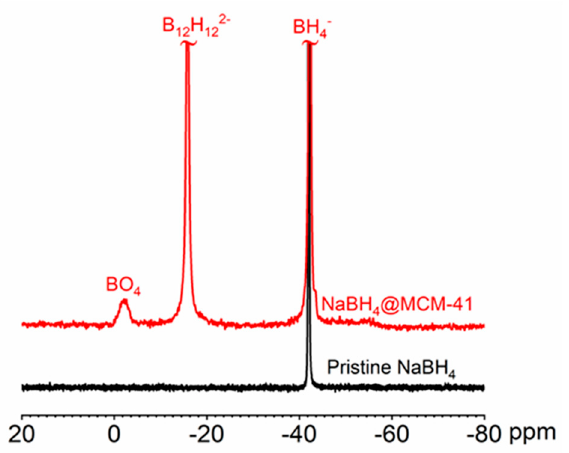
Figure 4. 11 B nuclear magnetic resonance (NMR) of pristine NaBH 4 @MCM-41 and NaBH 4 .